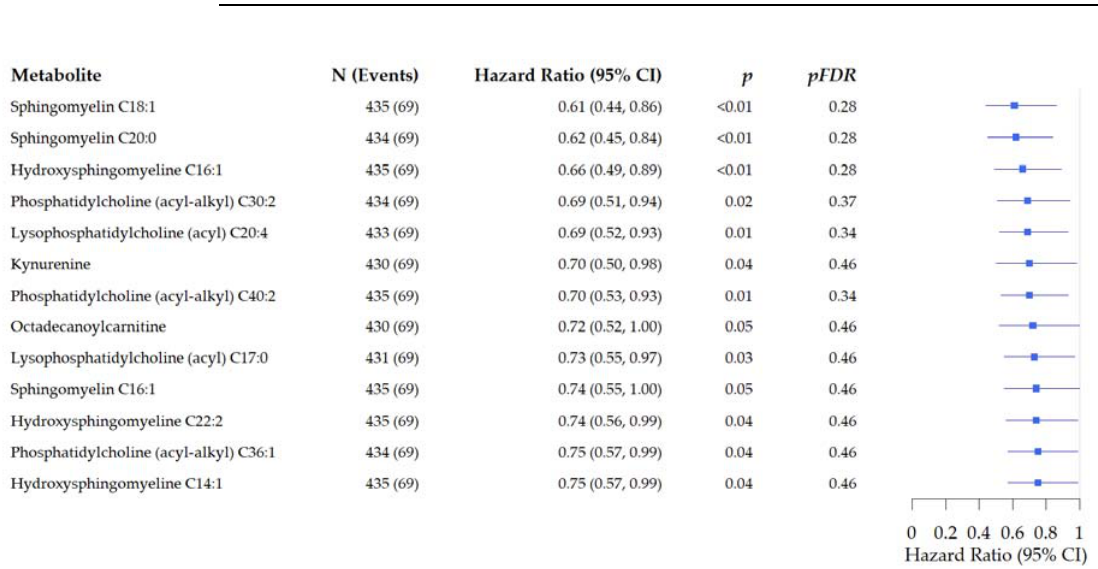
Figure 1. Forest plots of the associations of pre-surgery metabolite concentrations with risk of recurrence in prospectively followed colorectal cancer patients. Analysis is adjusted for age, sex, tumor stage, tumor site, BMI (kg/m 2 ), and study cohort. (Hazard ratio and 95% Confidence Interval).